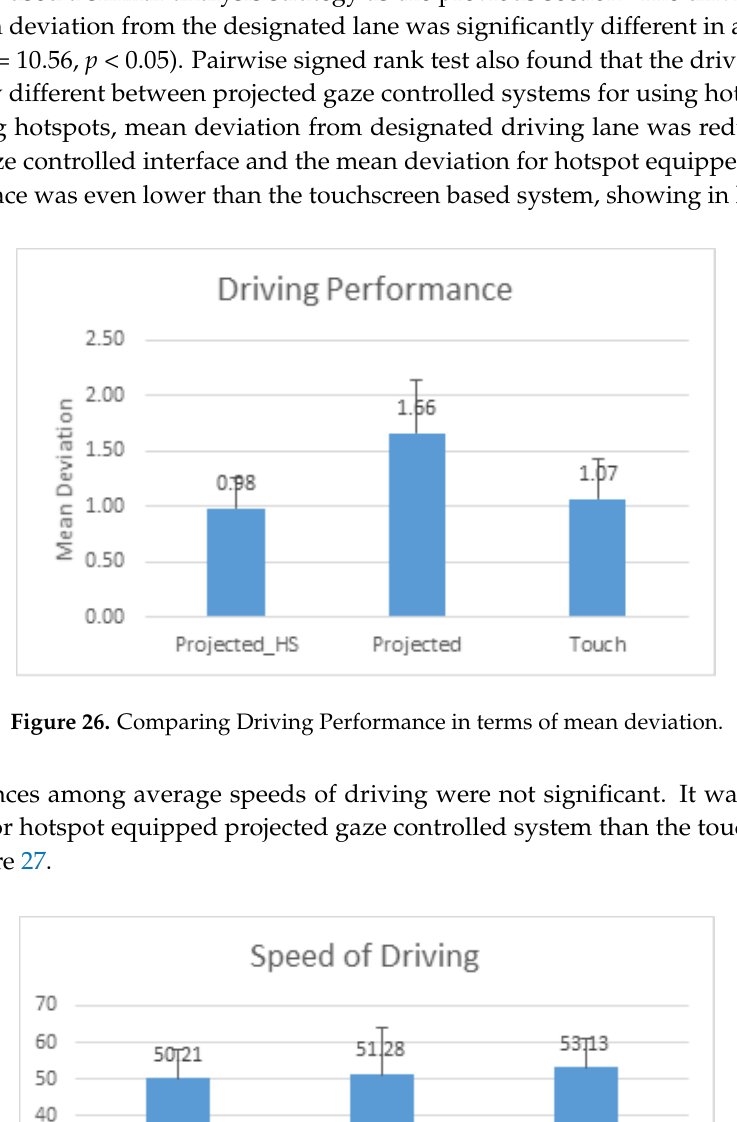
Figure 25. Set up of gaze controlled projects display.